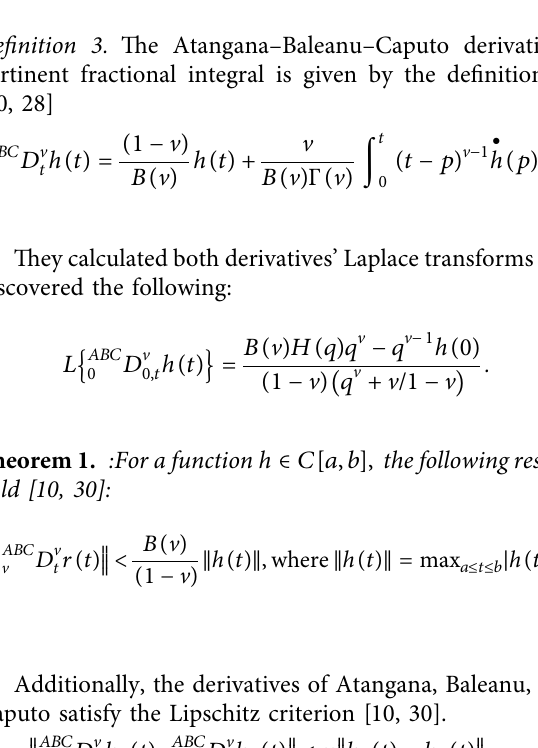
Figure 1: Flow chart of the COVID-19 fractional